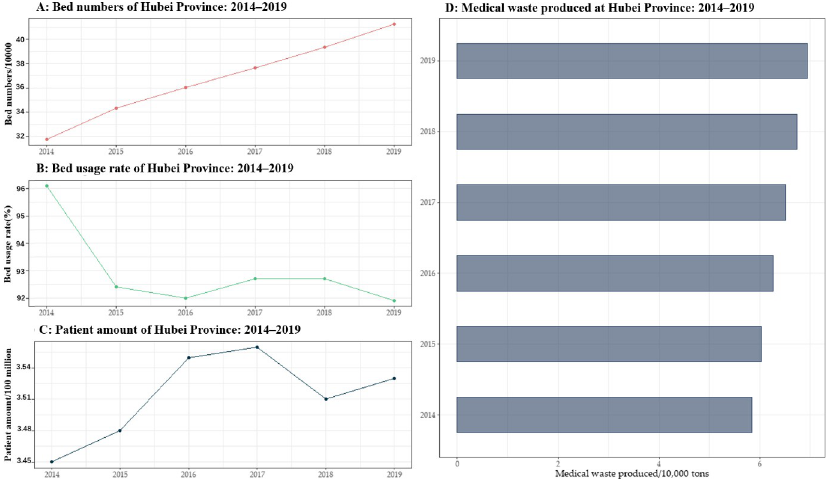
Fig 3. Graphs exhibiting the annual production of medical waste in the Hubei Province,